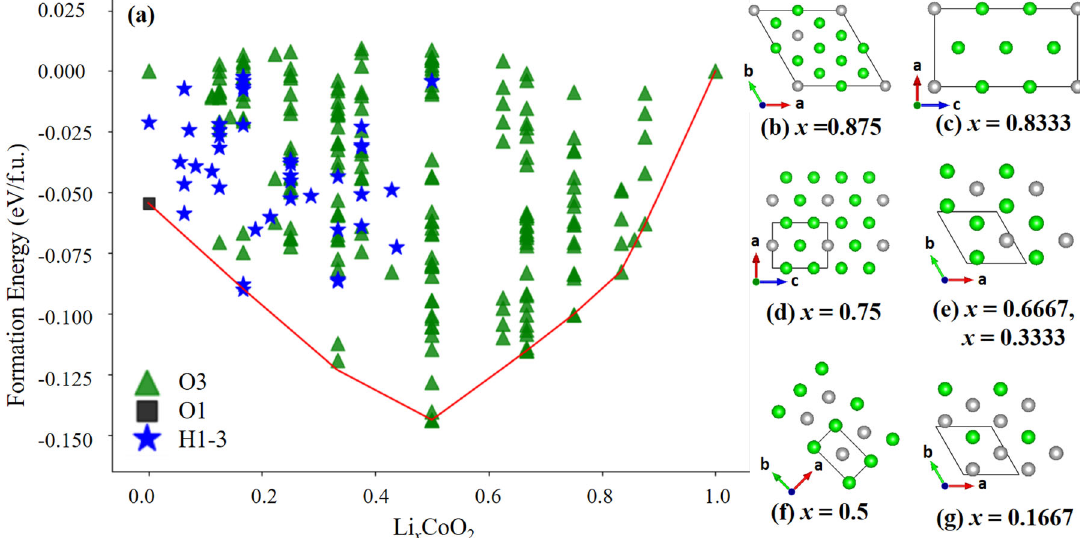
Fig. 1 Convex hull of Li x CoO 2 (0 < x < 1). a Formation energies (per formula unit, Δ E f ) of Li x CoO 2 . Ordered ground states at x = b 0.875, c 0.8333, d 0.75, e 0.6667, 0.3333, f 0.5, g 0.1667. Energies greater than 10 meV are discarded. The green and gray balls represent Li atoms and vacancies,